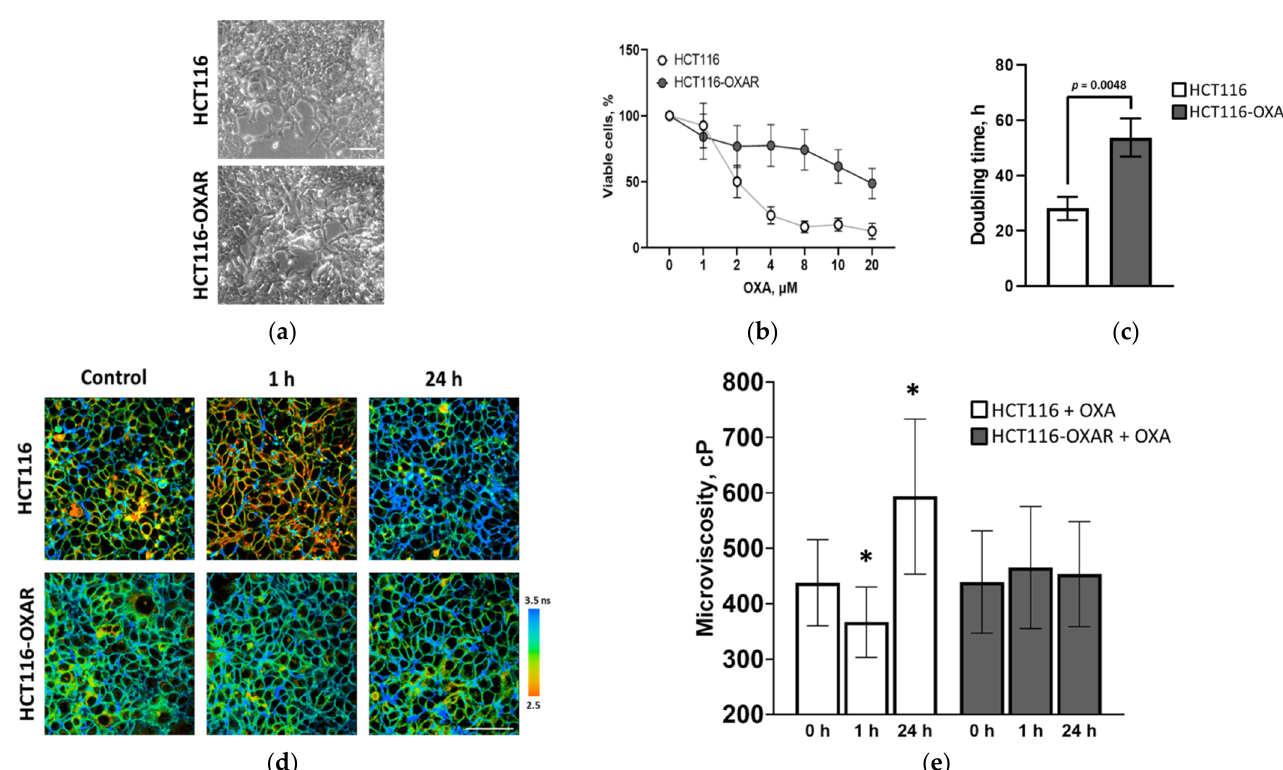
Figure 3. Viscosity of HCT116 and HCT116-OXAR cell membranes recorded during the treatment with oxaliplatin. ( a ) Phase-contrast microscopy of HCT116 and HCT116-OXAR cells. Bar is 100 μ m. ( b ) % viability in the presence of oxaliplatin (MTT-assay). ( c ) The doubling time. Mean ± SD. For characteristics of HCT116 cells adapted to different doses of oxaliplatin see Figure S1. ( d ) Representative FLIM images of sensitive and resistant HCT116 cells incubated with 2.0 μ M oxaliplatin for 1 h and 24 h and untreated controls. Staining with fluorescent molecular rotor BODIPY 2 (4.5 μ M). Ex. 850 nm, reg. 500–550 nm. BODIPY 2 demonstrated a monoexponential fluorescence decay in plasma membrane. Bar is 40 μ m, applicable to all images. ( e ) Quantification of viscosity of plasma membranes in HCT116 and HCT116-OXAR cells. Mean ± SD, n = 20–30 cells. Statistical significance was determined by ANOVA with Bonferroni post-hoc test. *, p ≤ 0.05 with control.